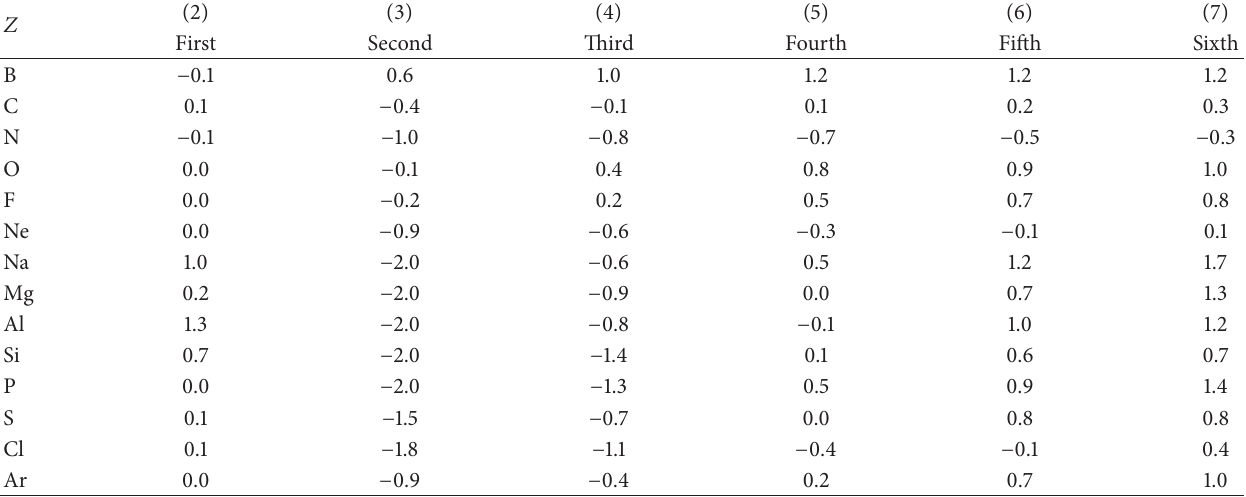
Table 5: Percentage difference between values shown in Tables 3 and